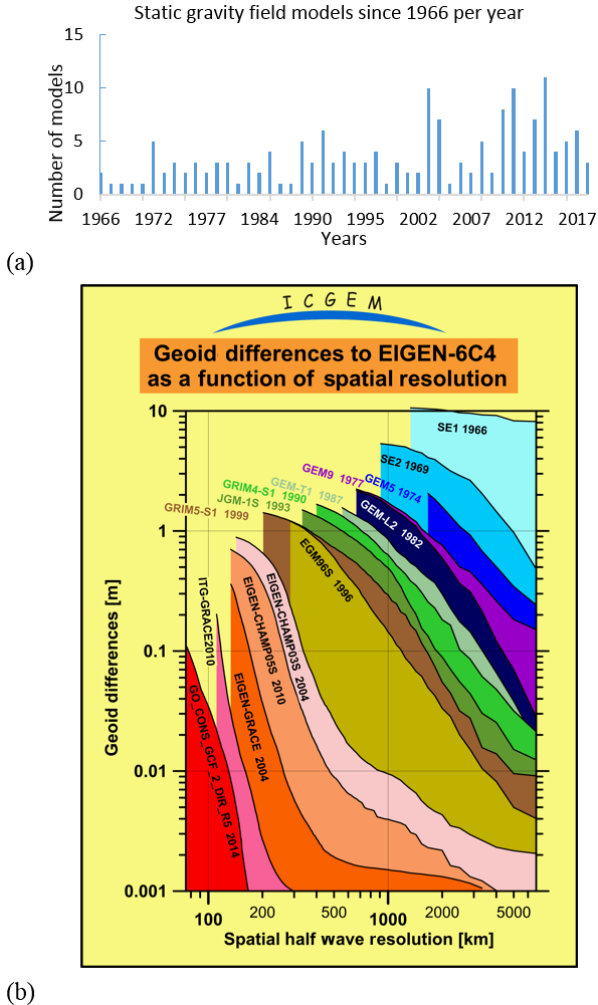
Figure 1. (a) Number of static gravity field models released per year since 1966. Note the increased number of models due to the launch of the dedicated satellite gravity missions (CHAMP, GRACE, and GOCE) after 2003 and 2011. (b) The history of the improvement of the spatial resolution and the accuracy of the satellite-only gravity field models. Signal amplitude difference over the years with respect to one of the latest combined global gravity field models, EIGEN-6C4 is shown (http://icgem.gfz-potsdam.de/ History.png, last access: 2 April 2019). Note that the EIGEN-6C4 is not the truth but a better approximation to the real gravity field, because it is a combination of data retrieved from satellite missions, terrestrial measurements, and altimetry-derived gravity field infor- mation. The uncertainties of the geoid signal have been reduced together with improved spatial resolution. See also the large im- provement between the EGM96S and EIGEN-CHAMP03 due to the contribution of the CHAMP measurements.